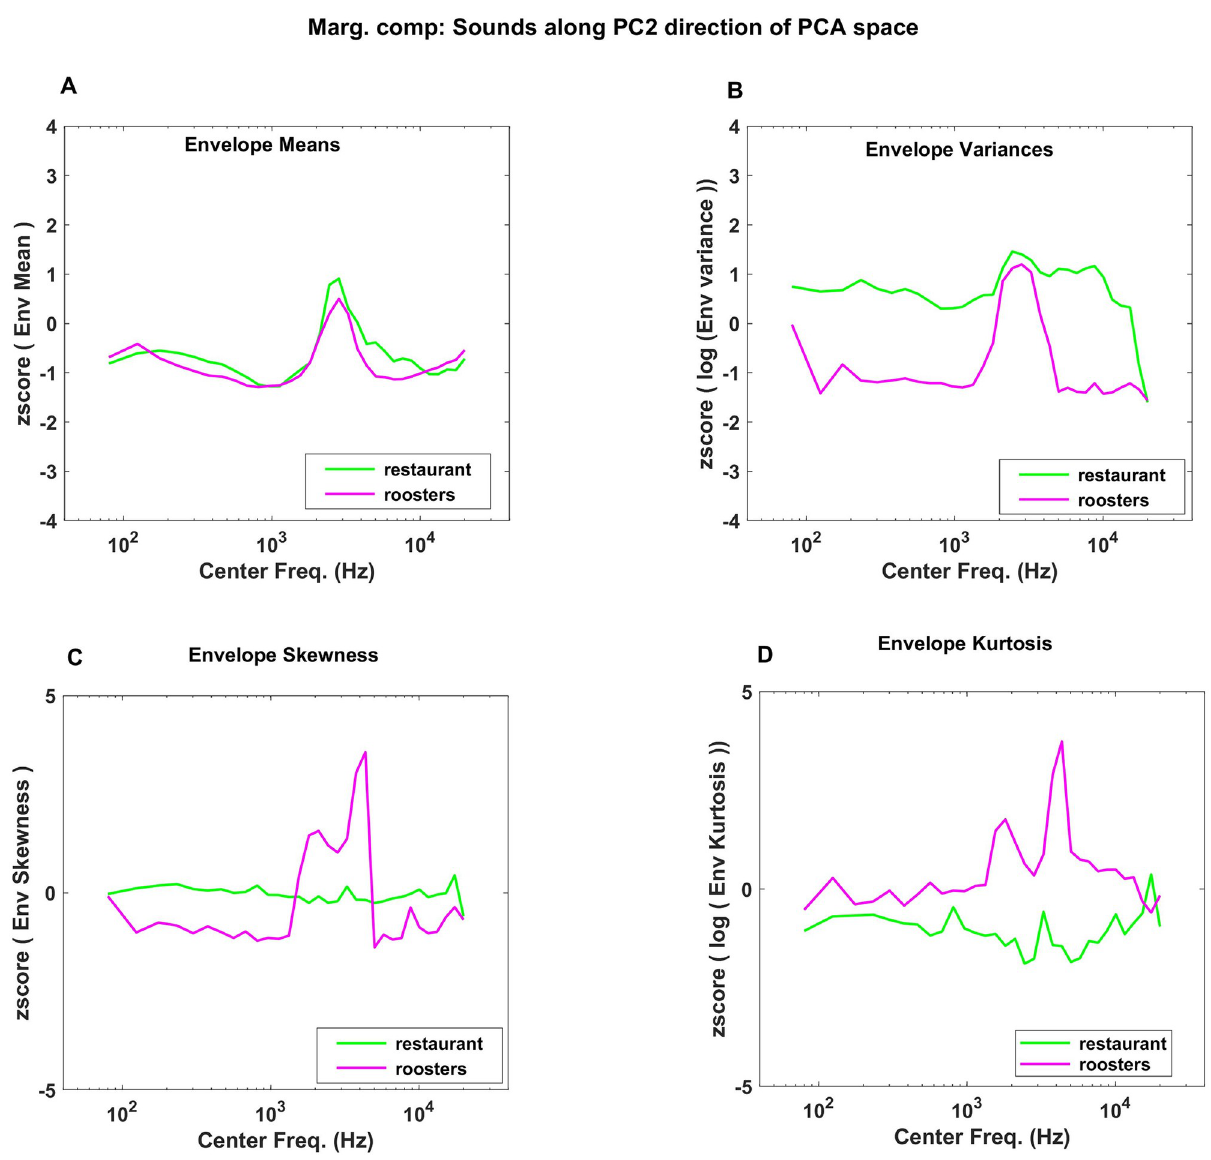
Fig 5. Comparison of “restaurant ambience” and “roosters” across PC2 dimension of marginal statistics. (A) “Roosters” has a lower mean for cochlear envelope than “restaurant” (B) “Roosters” has a higher variance cochlear envelope than “restaurant”. PC2 in Fig 3D indicates that as we move along the PC2, sounds should have opposing trends in mean and variance values of their cochlear envelopes. (C, D) As we move in the PC2 direction “skew” and “kurtosis” should be higher. “roosters” has higher skew and kurtosis than “restaurant”.